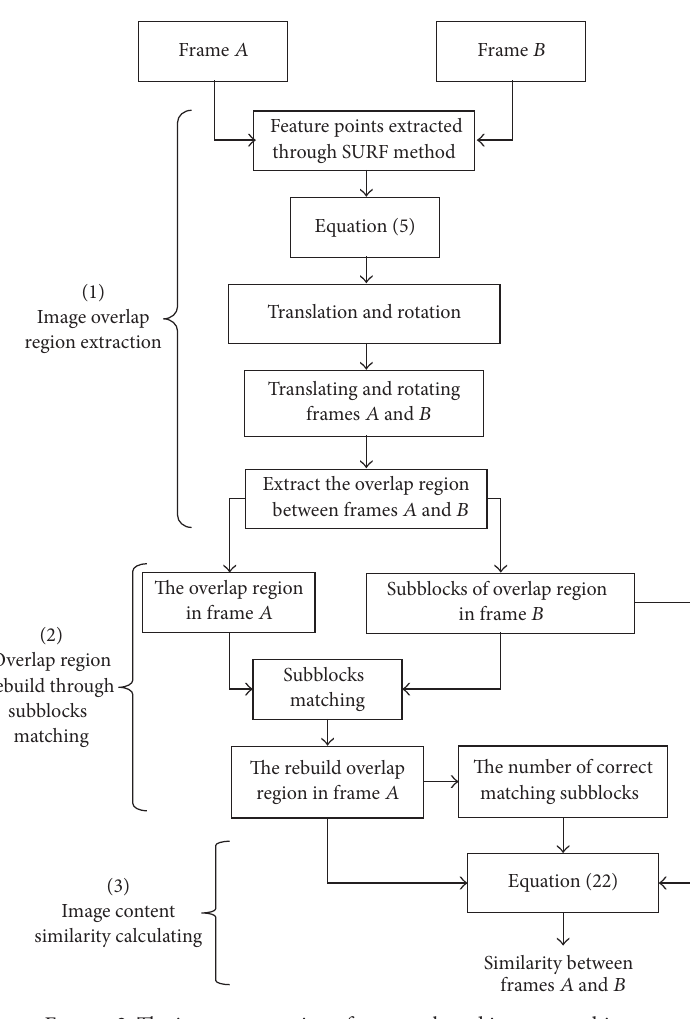
Figure 2: The image processing of content-based image matching.